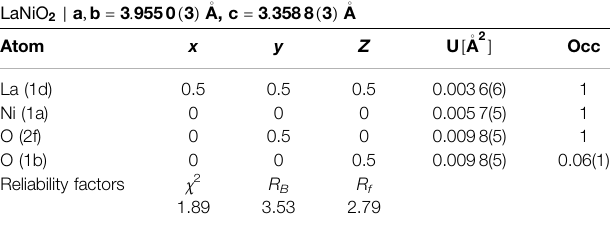
TABLE 1 | Re fi ned atomic coordinates of LaNiO 2 in tetragonal space group P 4/ mmm with preferred orientation extracted from powder neutron diffraction data at 1.5 K ( Figure 3